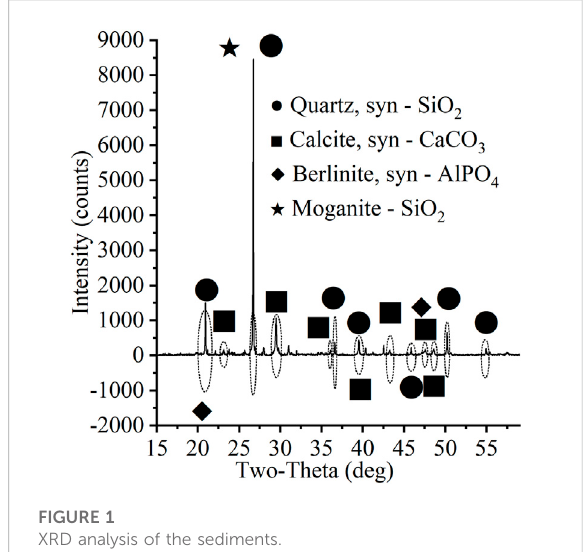
FIGURE 1 XRD analysis of the